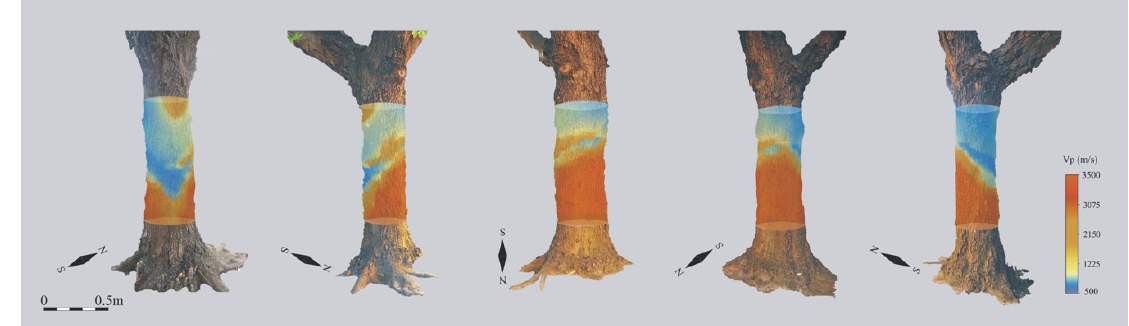
Figure 11. Different views of the 3D tomographic model.